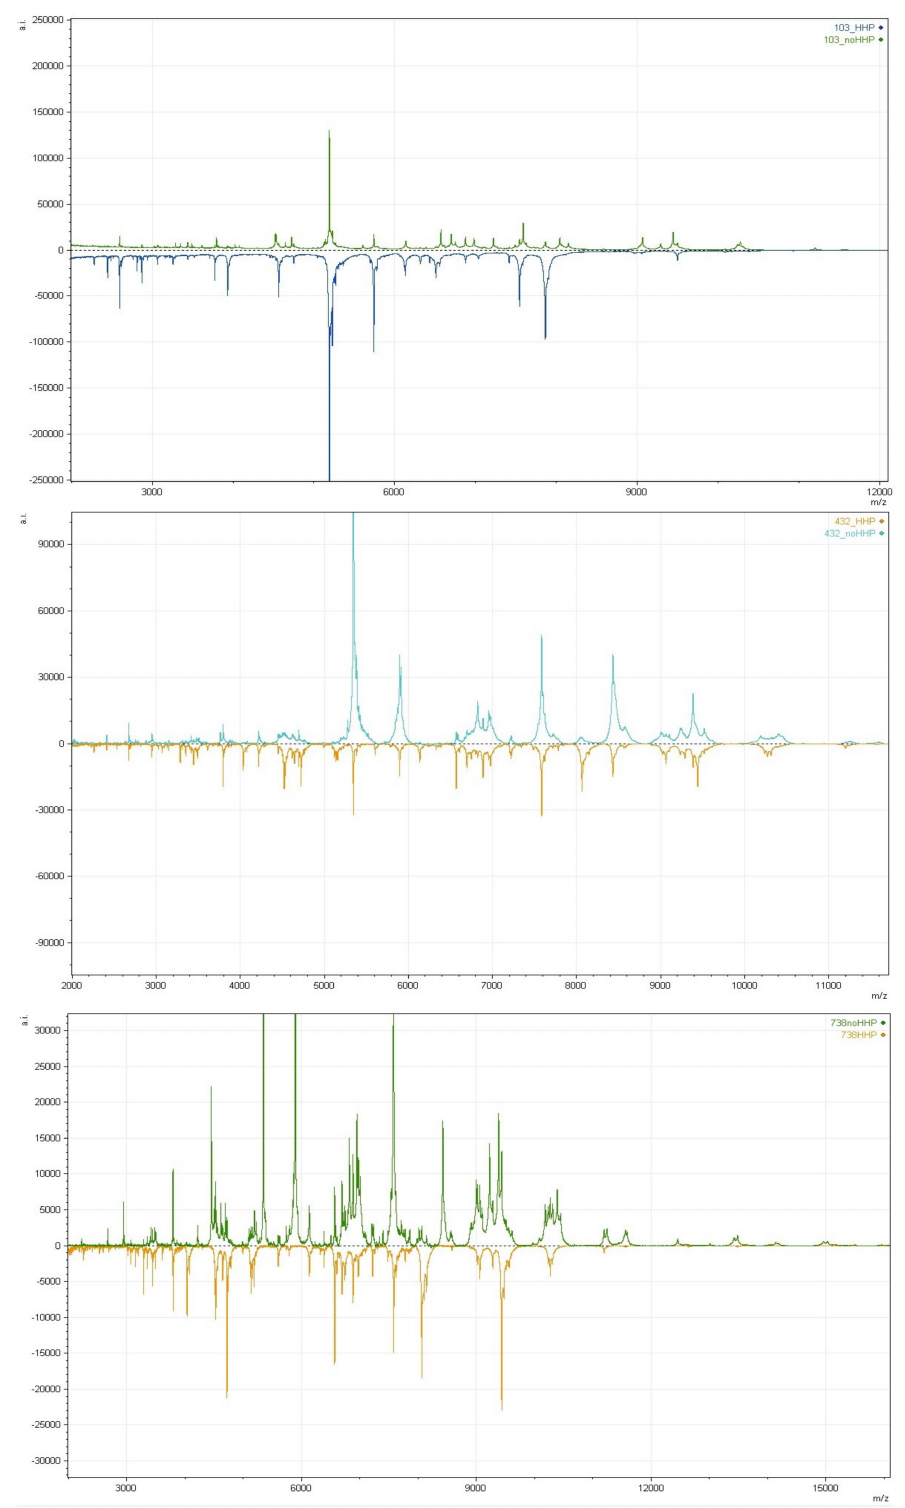
Figure 5. MALDI-TOF MS mass spectra obtained from the Lactobacillus strains (133, 432 and 738) that yielded di ff erent MPS identification results for the unpressured (noHHP) and pressured with 300 MPa / 5 (cid:48) (HHP)